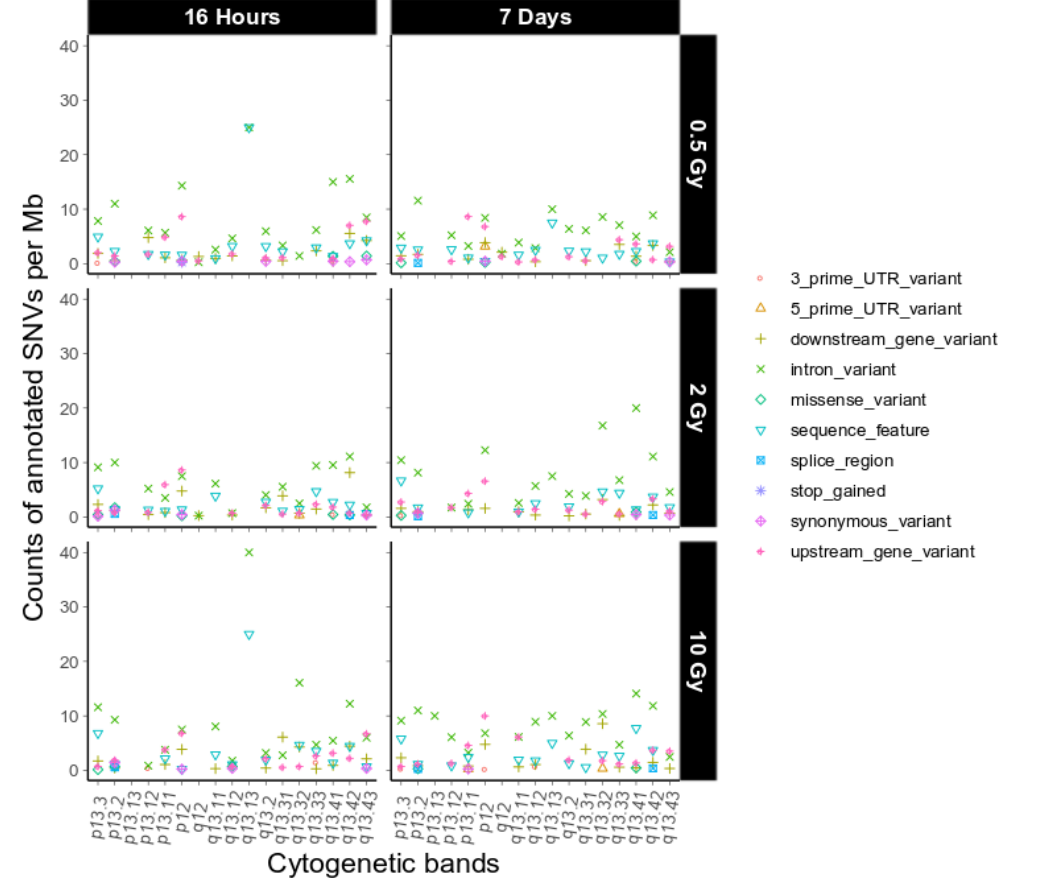
Figure 4. Sequence ontological information for the IR-induced variants observed on chromosome 19 over cytogenetic band, filtered for refseq IDs for dataset 1. For further explanation of the used combination of sequence ontology terms see Section 4.9. Functional Annotation.